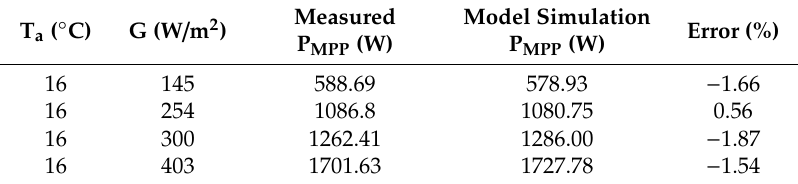
Table 4. System 1 experimental